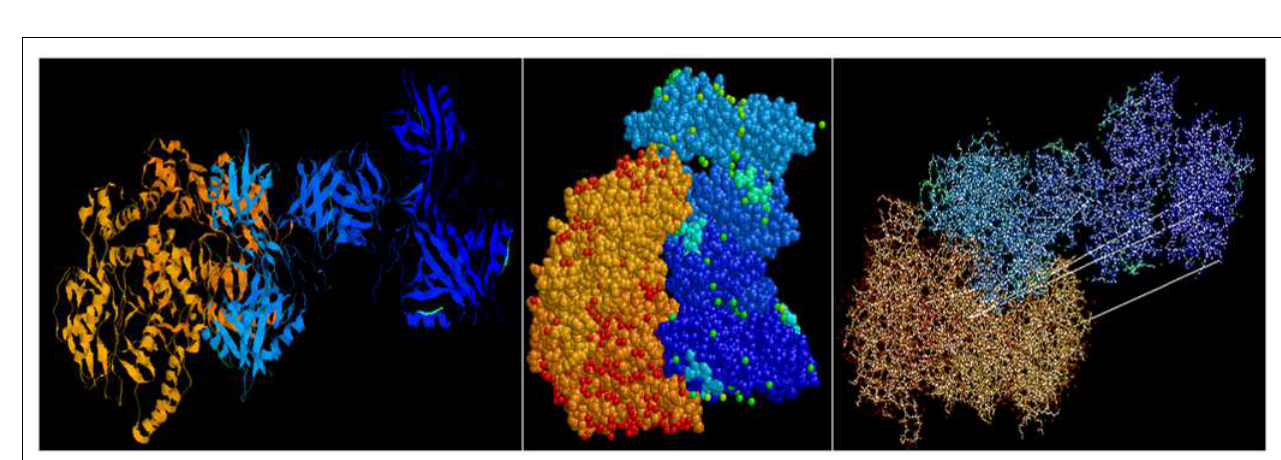
3D structures. Prediction of structural alignment based on lowest energy levels were visualized for ribbons and ball and stick structures using RASMOL and depicted here from different angles. Patchdock software uses surface configurations of folded proteins to predict interactions using computer vision technology (74–76) and is currently being used in neuroinformatics